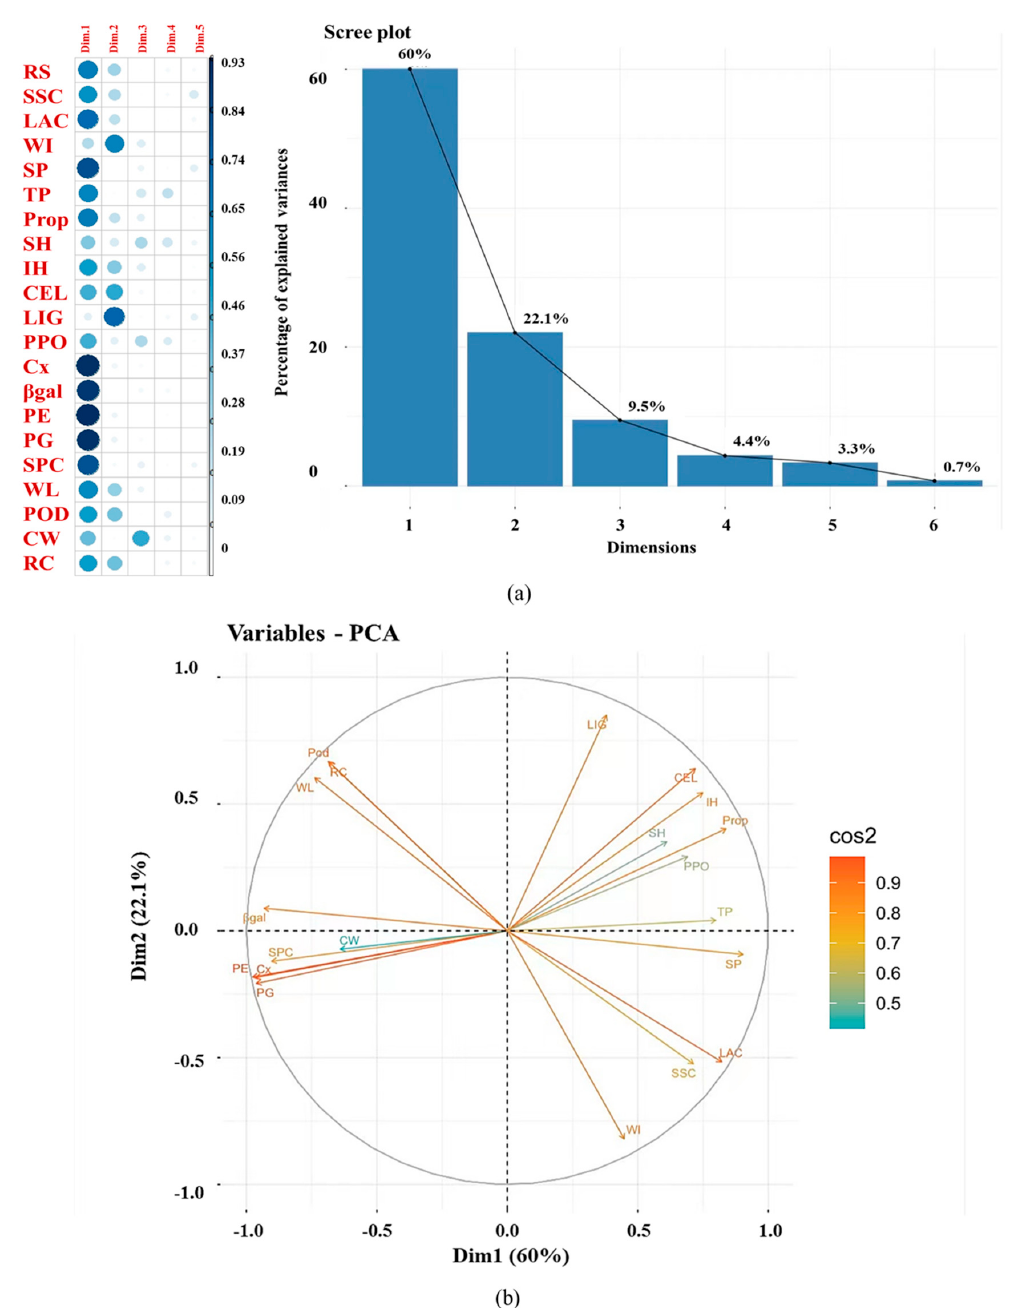
PG, and β -gal) were distal from the center of the plot and were involved in the changes in cell wall composition during the postharvest storage of Z. latifolia .